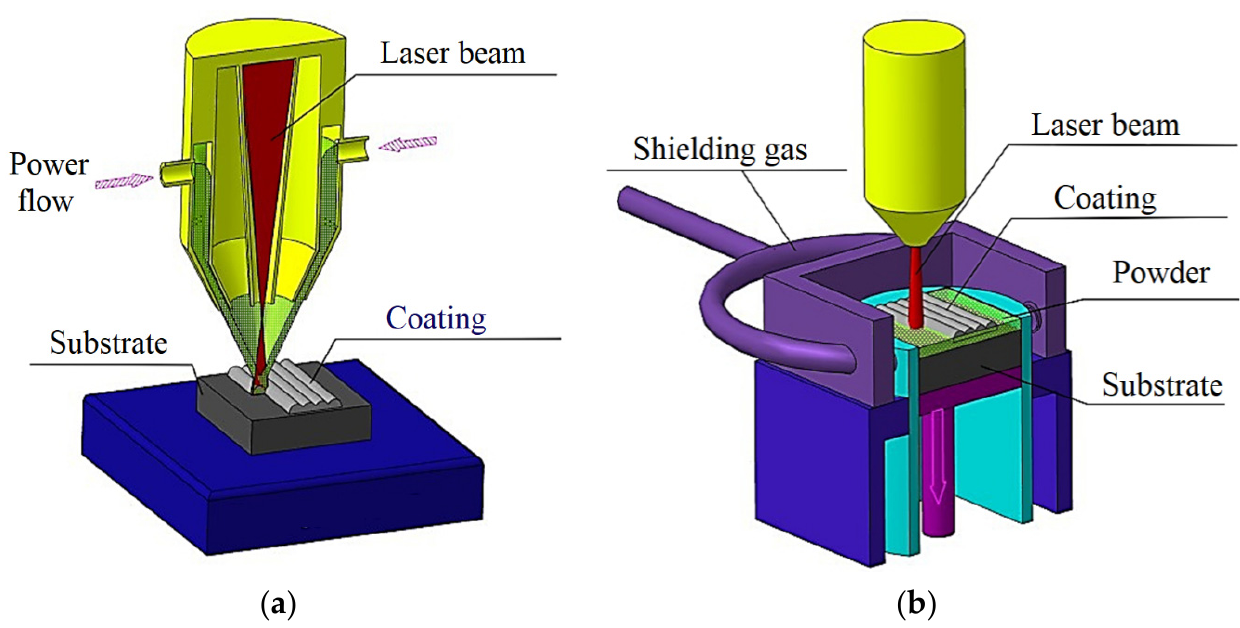
Figure 2. Schematic representation of laser technologies: ( a )-direct metal deposition technology (DMD) ( b )-laser surface cladding technology (LSC).